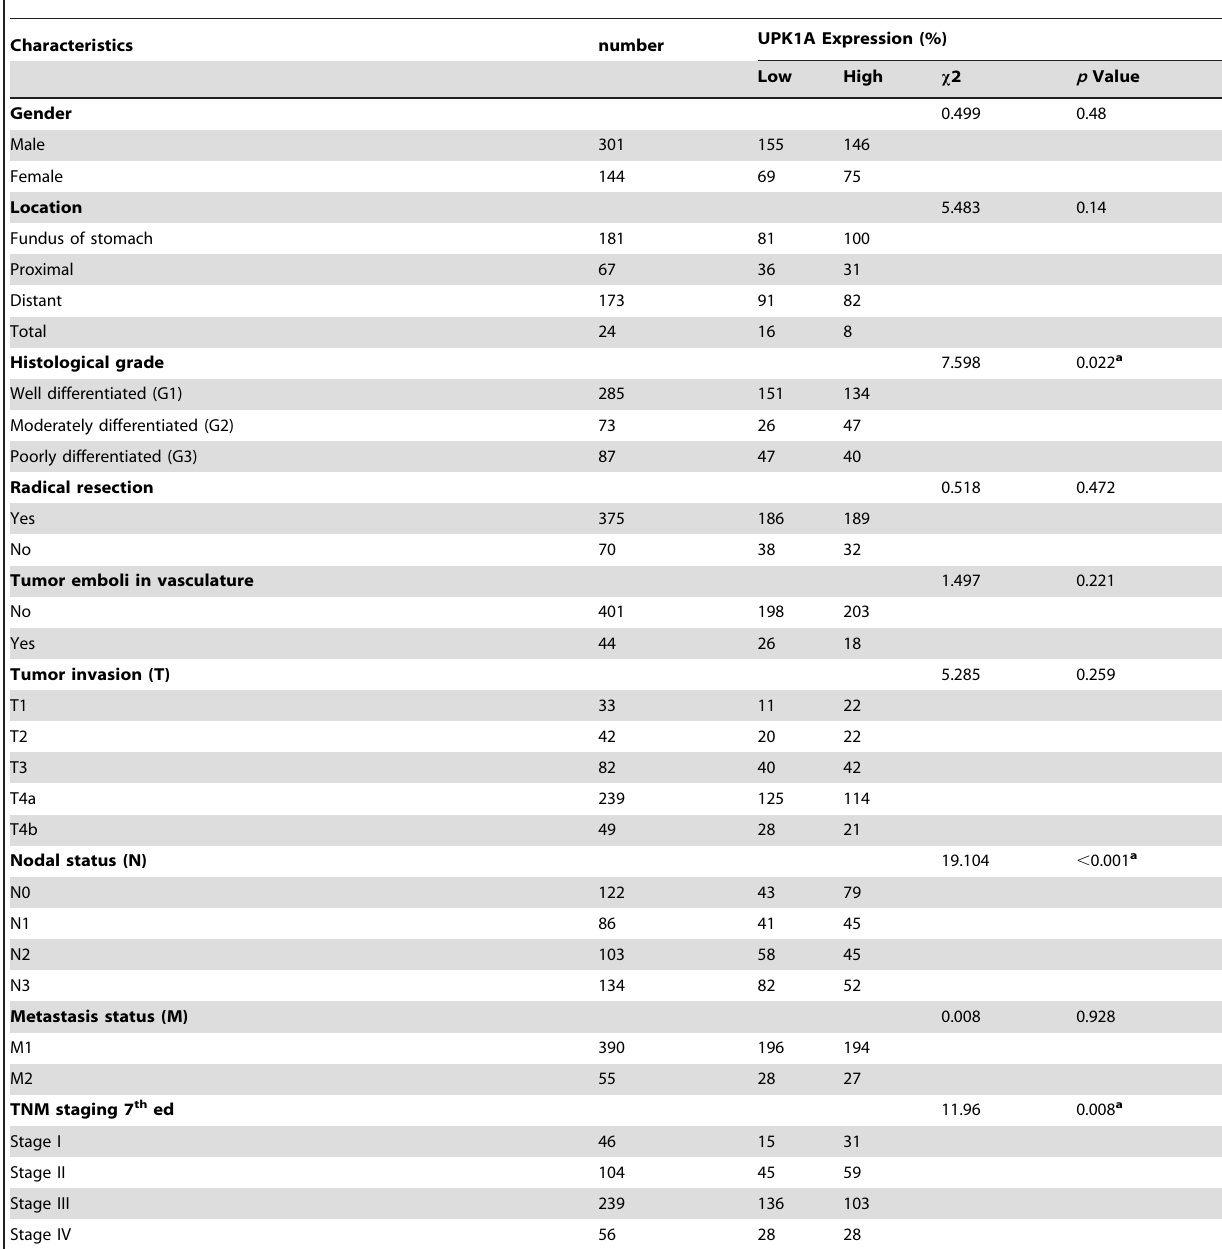
Table 1. The Expression of UPK1A and the Clinicopathologic Characteristics of Patients with Gastric Cancer.